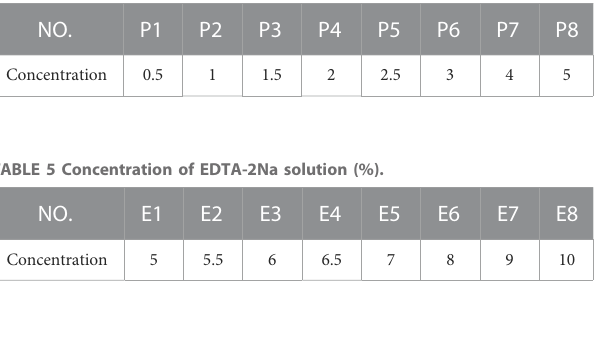
TABLE 6 Concentration of mixed solution of SHMP and EDTA-2Na (%).